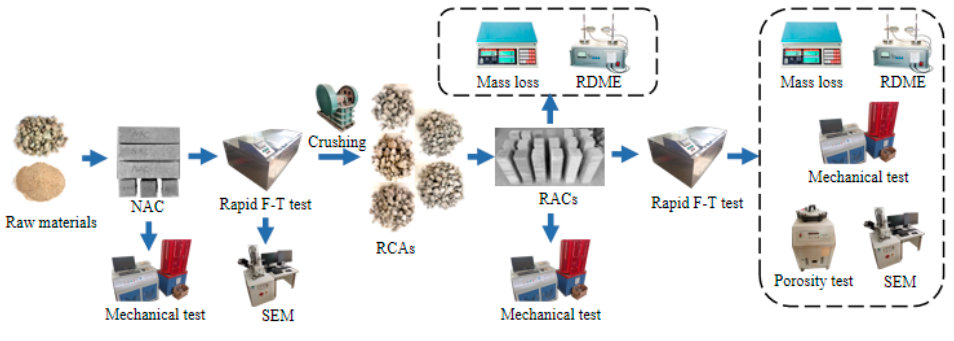
Figure 3. Experimental